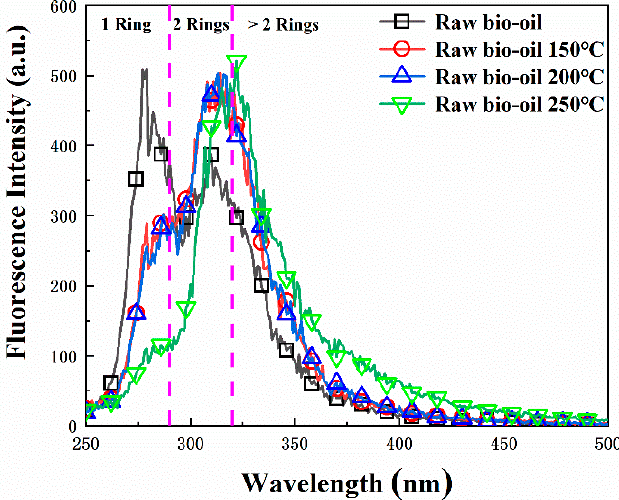
Figure 7. UV fl uorescence spectra of raw bio-oil hydrodeoxygenation at 150 °C, 200 °C, and 250 °C. Figure 7. UV fluorescence spectra of raw bio-oil hydrodeoxygenation at 150 ◦ C, 200 ◦ C, and 250 ◦ C.